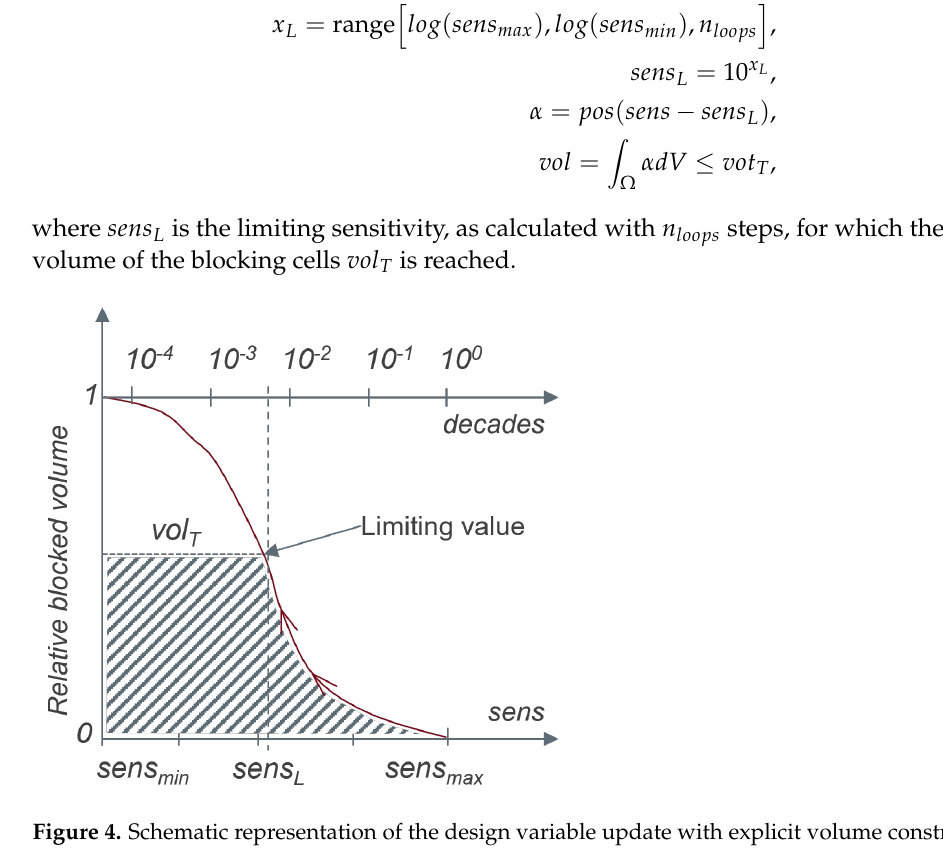
Figure 4. Schematic representation of the design variable update with explicit volume